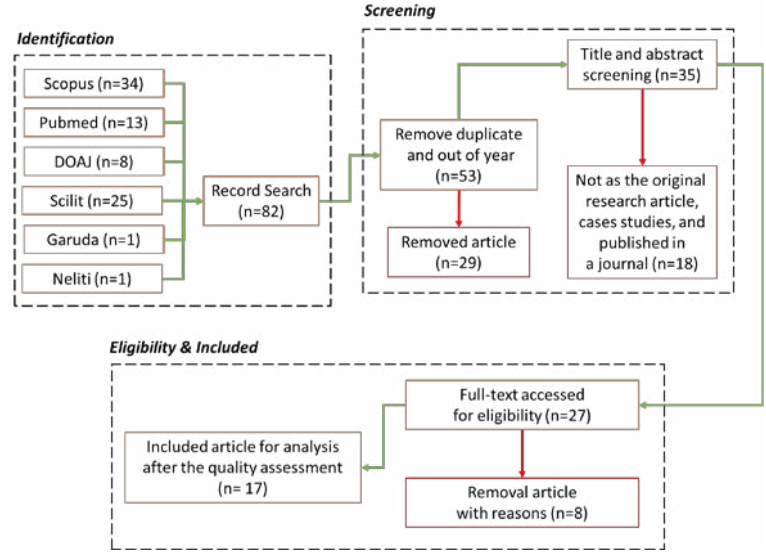
Fig. 1: Selecting processes for articles in the SLR